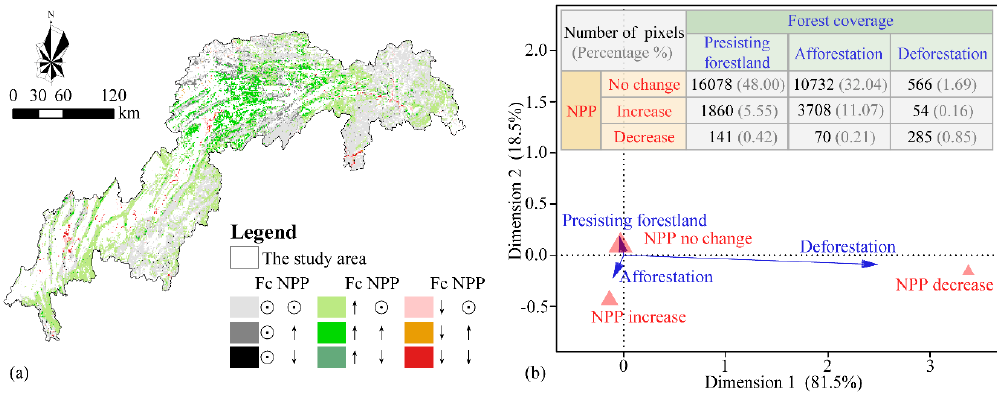
Figure 7. Spatial coupling map ( a ) and correspondence analysis; ( b ) between NPP change and forest change. Note: In the figure ( a ), Fc is an acronym for forest coverage, while ⊙ , ↑ and ↓ indicate no change, increase, and decrease, respectively.